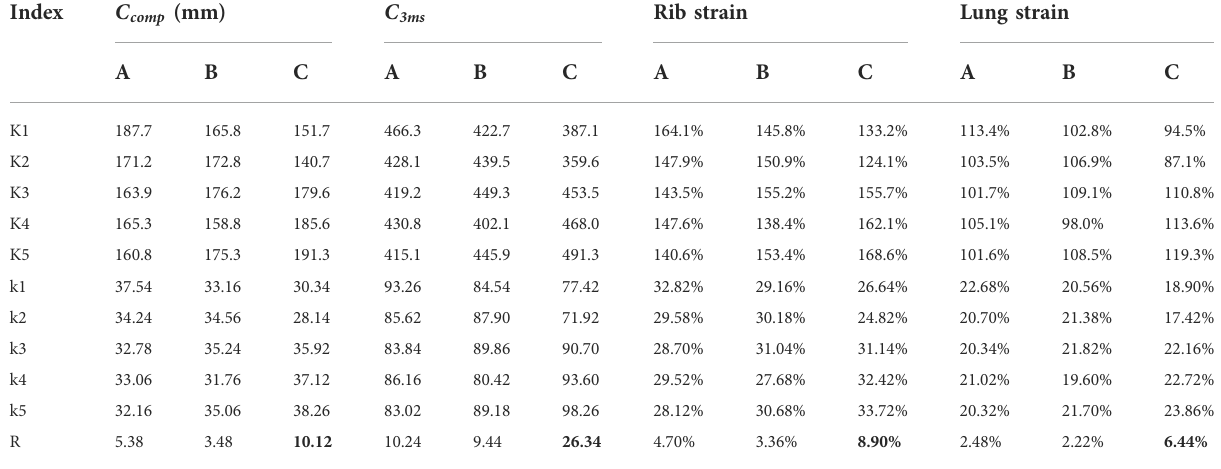
TABLE 5 Simulation results of the driver ’ s chest injury